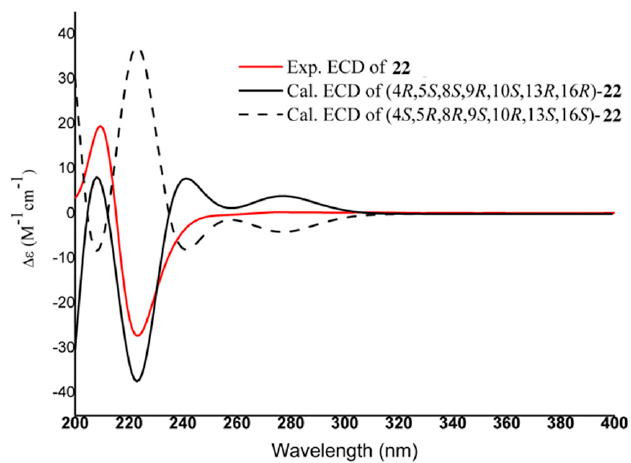
Figure 7. Experimental and calculated ECD spectra of compound 22. Table 2. The 1 H and 13 C-NMR data of compound 22 (600/150MHz, CD 3 OD, δ in ppm, J in Hz).